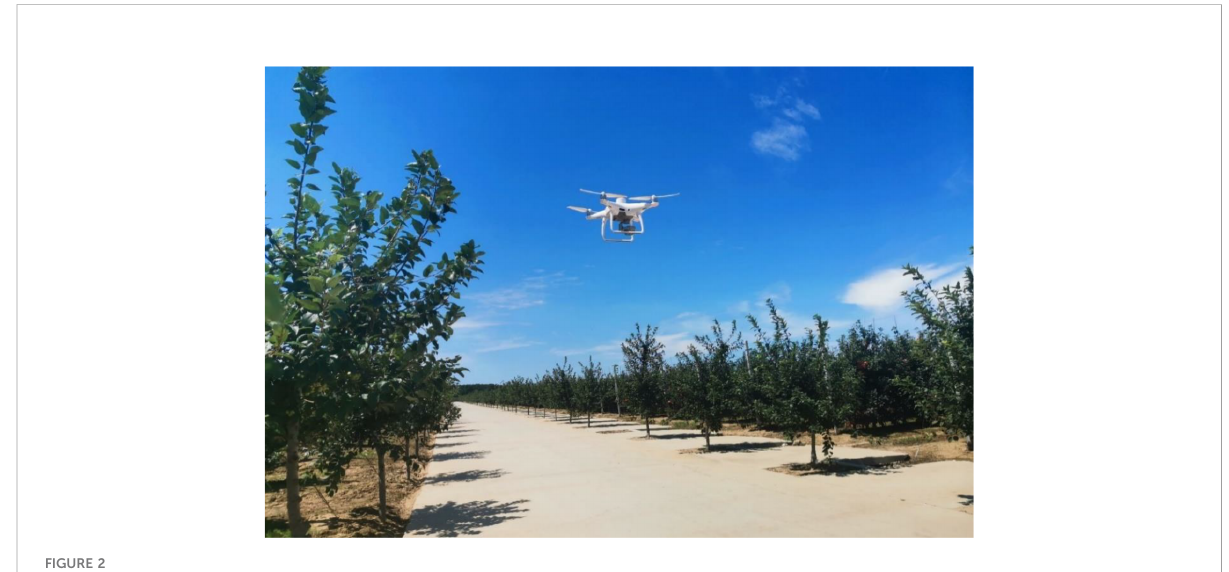
FIGURE 2 The DJI P4